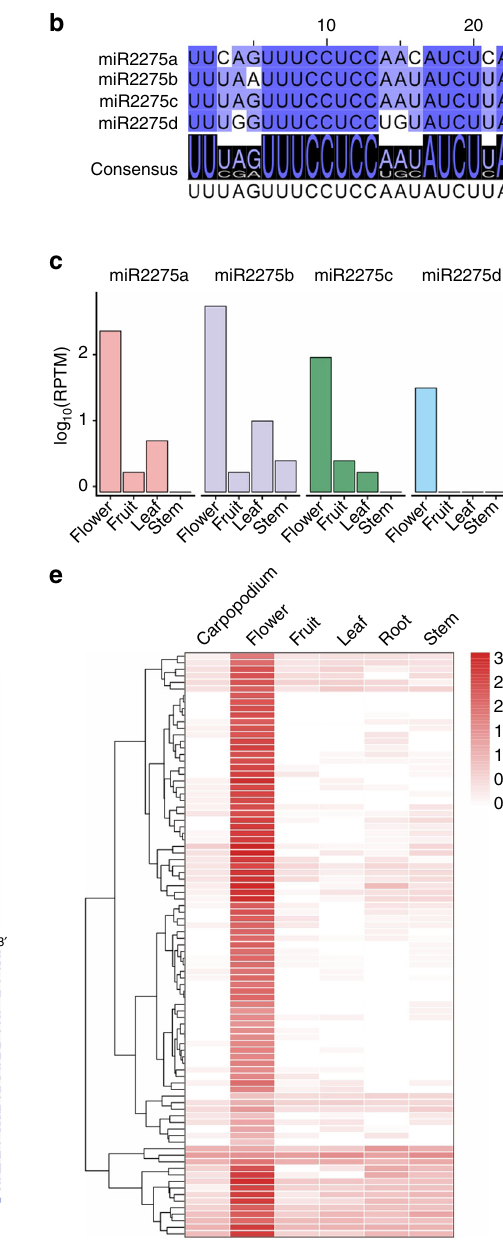
Fig. 1 miR2275-triggered 24-nt reproductive phasiRNAs are abundant in litchi. a Stem – loop regions of two MIR2275 precursors in litchi. miR2275 and miR2275* sequences are marked in red and orange, respectively. Bulges within the miR2275/miR2275* duplexes are indicated by a cyan circle. b Alignment of all expressed members of the miR2275 family in litchi. The degree of conservation for each nucleotide is represented by the color, with a dark color denoting a high level of conservation and a light color denoting a low level. The consensus sequence of the alignment is displayed below with sequence logos. c Expression of miR2275 members in four litchi tissues. d Above: alignment of miR2275 duplex and its target sites in 24- PHAS loci in litchi. The nucleotide pairing at each position between miR2275 and miR2275* is indicated by different colors, with A:U/C:G matches denoted in green, G:U matches in purple, and all mismatches in pink. Below: nucleotide sequence alignment of 24- PHAS loci with sequence similarity denoted by the density of blue color, demonstrating no conservation outside of the miR2275 target site (as in grass 24- PHAS loci). e Accumulation of 24-nt phasiRNAs in different tissues of litchi, with each row denoting a 24- PHAS locus, and each column a tissue as indicated. The key at right indicates the abundance in units of log2